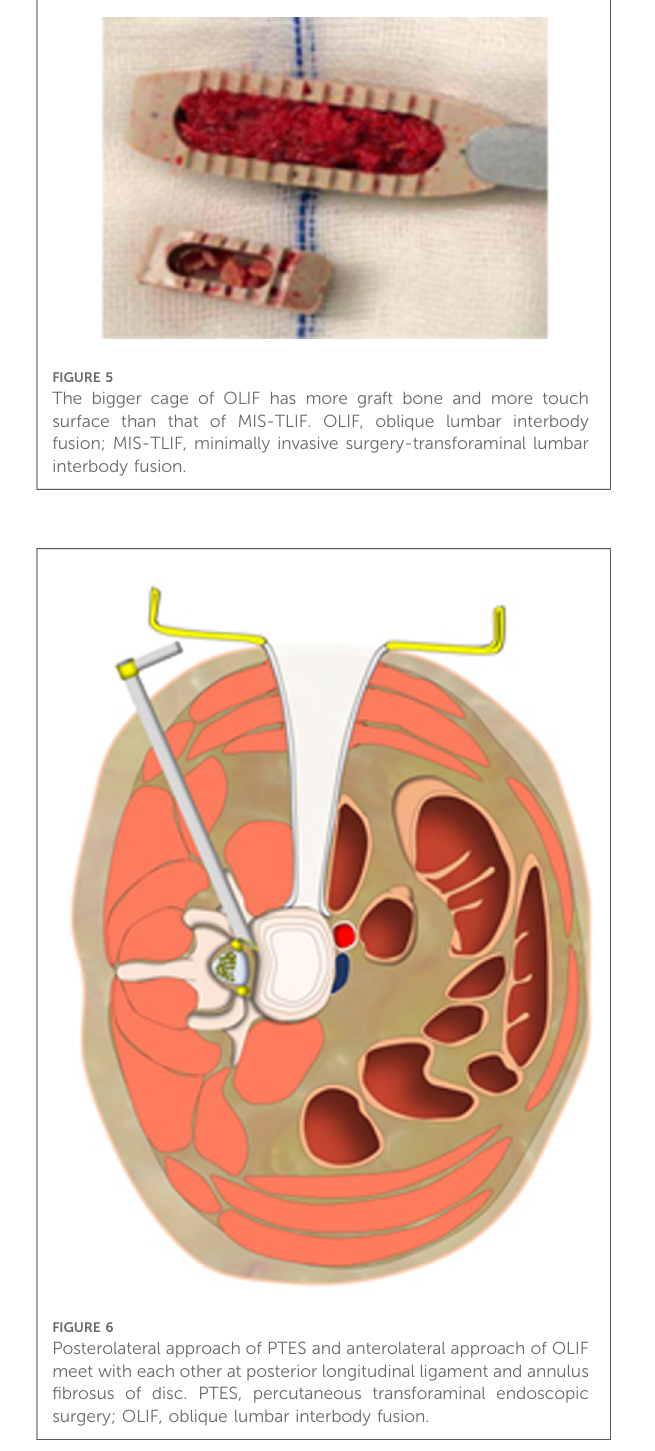
screws rod fi xation. This combination of two minimally invasive surgeries protects the paraspinal muscles and bone structures as much as possible. MIS-TLIF does not destroy the attachment of paraspinal muscles to bone, supraspinal, and interspinal ligaments, but splits the paraspinal muscles and removes